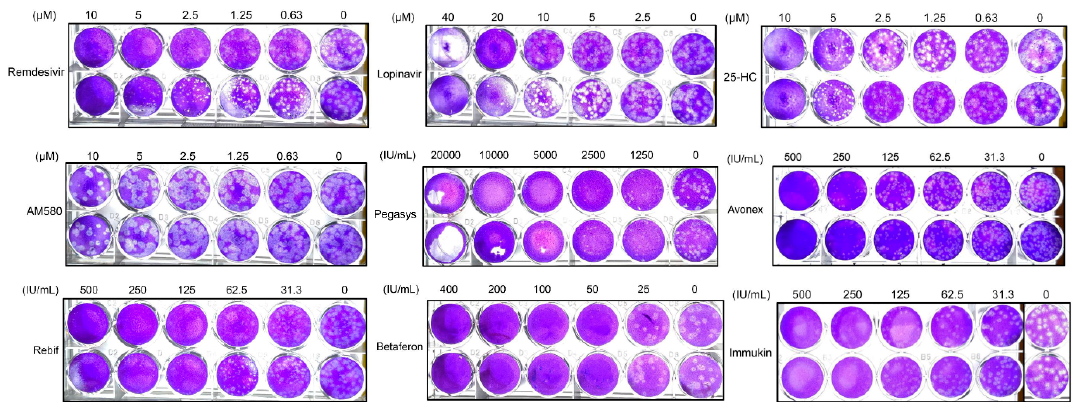
Figure 4. SARS-CoV-2 plaque reduction assay. Fifty plaque-forming units of SARS-CoV-2 were added to each well of VeroE6 cell monolayers with or without the addition of the indicated antiviral agents and the plates were then incubated for 1 h at 37 °C in 5% CO2 before removal of unbound viral particles by aspiration of the media and washing once with DMEM. Monolayers were overlaid with media containing 1% low melting agarose in DMEM and different concentrations of the antiviral agents, inverted and incubated for another 72 h. The wells were then fixed with 10% formaldehyde overnight. After removal of the agarose plugs, the monolayers were stained with 0.7% crystal violet and the plaques counted. The experiments were performed in triplicate and repeated twice for confirmation. Abbreviation: 25-HC, 25-hydroxycholesterol. Table 2. Antiviral activities and cytotoxicities of the anti-SARS-CoV-2 antiviral agents identified in the primary screening.